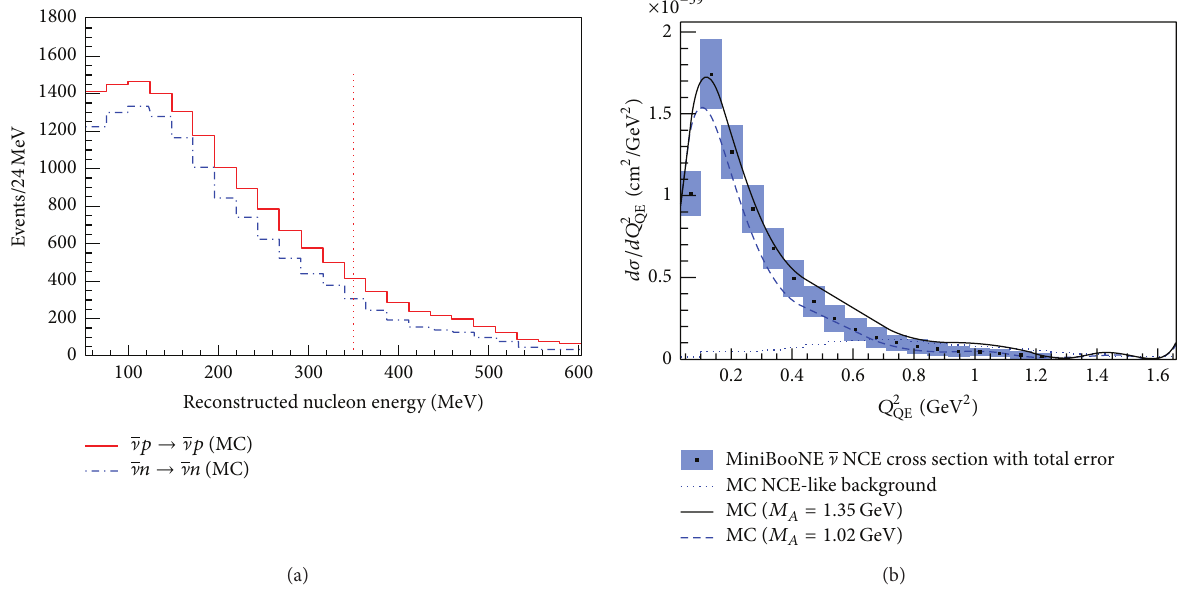
Figure5:(Coloronline)MiniBooNENCEresults[45].(a)showssimulatedkineticenergyofprotonsandneutronsfromNCEinMiniBooNE. The line denotes the Cherenkov threshold, that is, only protons which have higher energy from this line emit Cherenkov radiation. (b) shows the antineutrino NCE differential cross section. As you see, the data shows a “roll-over” in the low 𝑄 2